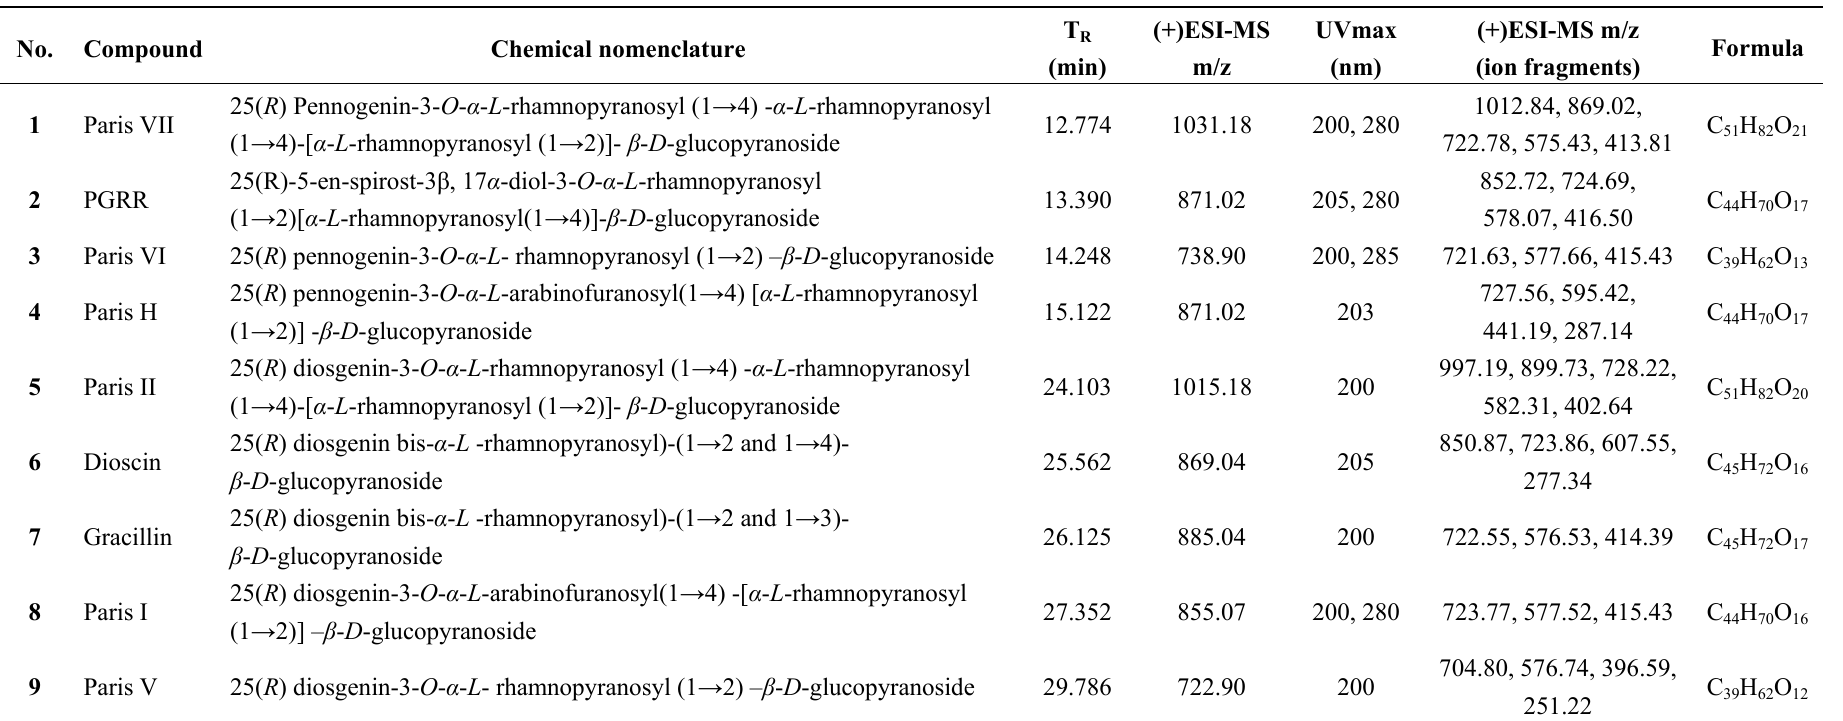
Table 1. The retention time, UVmax and MS ion fragment information of PRS using HPLC-DAD and LC-ESI/MS/MS.